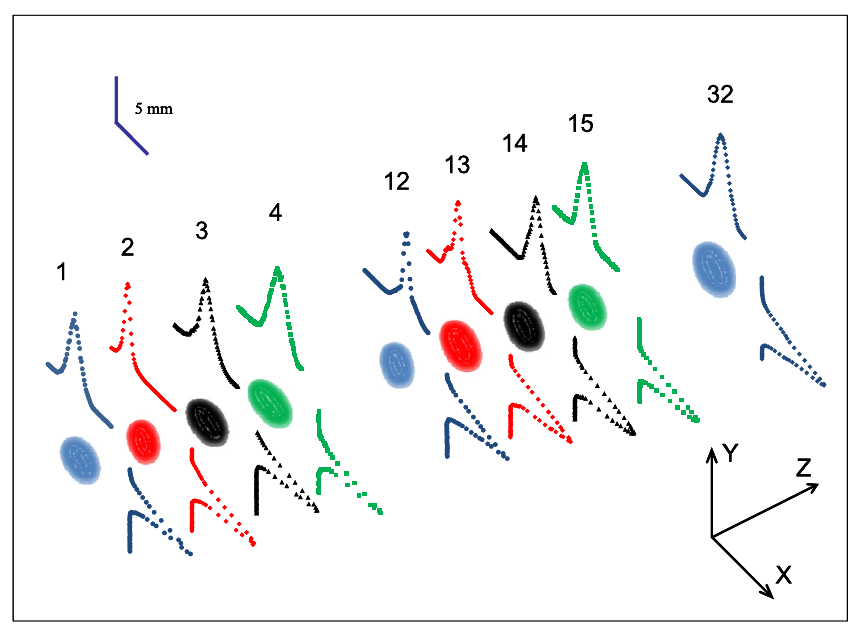
FIG. 7. All nine pairs of profiles simultaneously measured by the laser wire system. The measurement takes about 2 minutes for each axis. Numbers represent cryomodule in the SCL. The H (cid:1) beam is propagating along the Z direction. Profiles are plotted in the XY plane with horizontal profiles on the top. All profiles are plotted with the same scale in space. Scale bars represent 5 mm. Each elliptic shape represents the distribution of the H (cid:1) beam with the measured beam